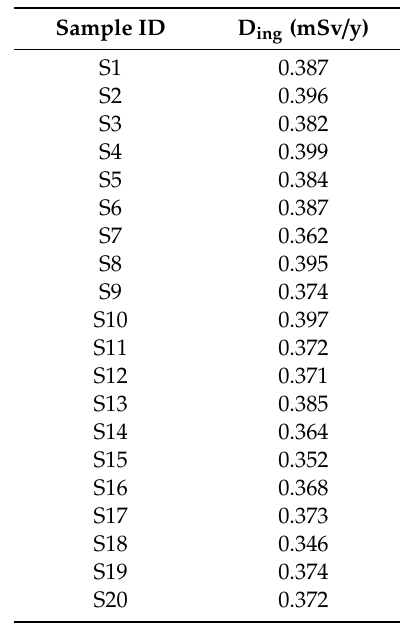
Table 4. The annual e ff ective dose due to the ingestion of investigated samples for the age category higher than 18